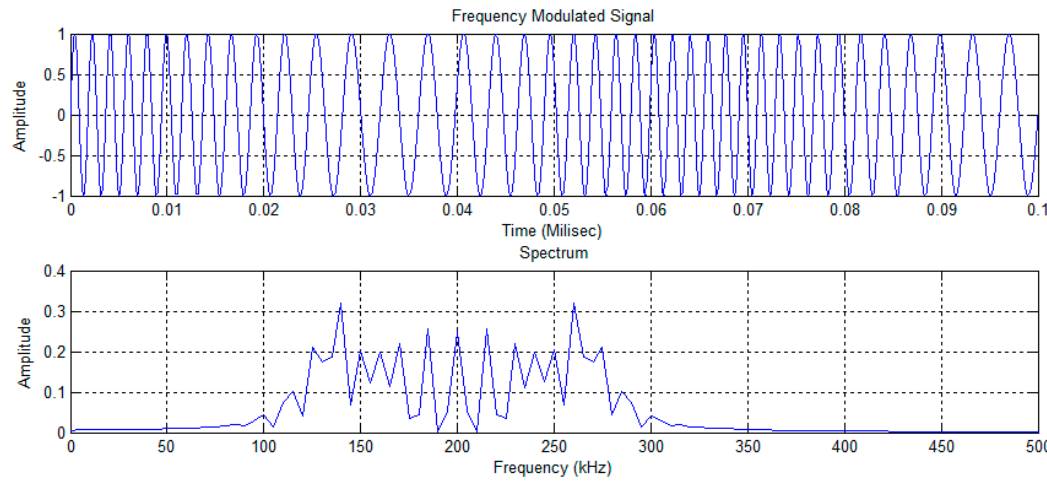
Figure 2. The frequency modulated waveform used as the excitation signal. Both the time series ( top ) and the frequency content ( bottom ) of the signal are shown.